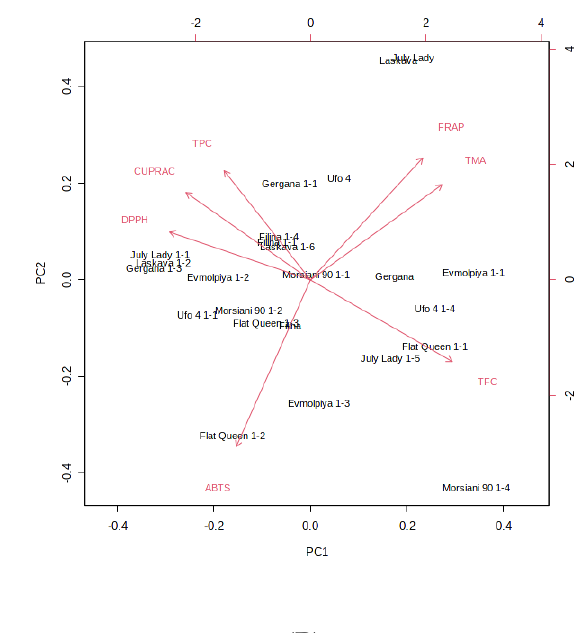
Figure 3. Principal component score plot ( A ) and eigenvector load values ( B ) of GC−MS data of volatile compounds of peach ( Prunus persica L.) peels for the eight peach peel varieties.